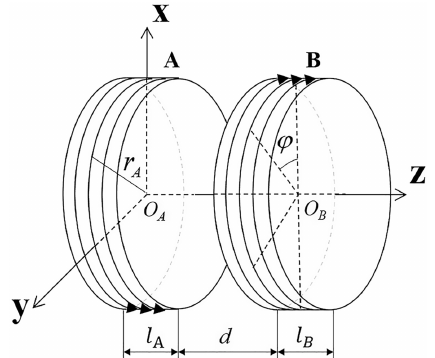
Figure 6. The positions of magnetizing currents on the surface of cylindrical magnets in the coordinate